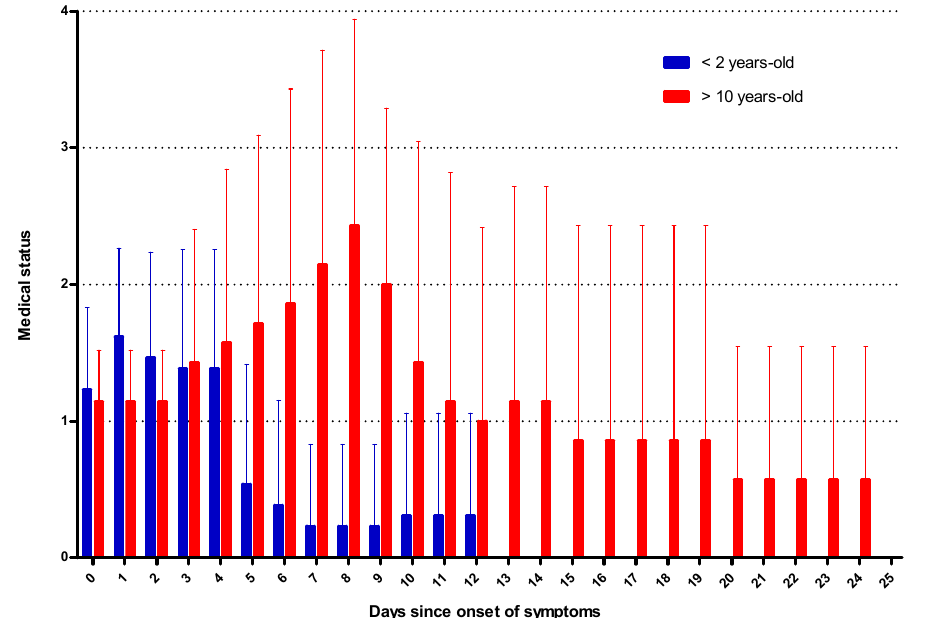
Figure 2. Graphical timeline of the clinical evolution of the 21 children with symptomatic COVID-19. Medical status was determined daily for each patient from the onset of symptoms (day 0) until discharge home and scored from 0 to 4: 1 = presence of symptoms, 2 = hospital admission, 3 = oxygen therapy, 4 = ventilatory support (non-invasive ventilation (NIV) or mechanical ventilation) and 0 = discharge. The data are the mean of the daily medical status scores in each age group ( < 2 years old in blue and > 10 years-old in red) from the onset of symptoms. Error bars show standard deviations. As only one patient showed symptoms in the 2–10-year-old group, this age group is not represented in this figure. This figure illustrates that in the youngest patients, the disease is symptomatic at the onset but has a rapid positive outcome, whereas, in older children, the severity subsequently increases, sometimes requiring intensive care and longer hospitalizations. Table 3. Evolution of the 21 children with symptomatic SARS-CoV-2 infection. Evolution